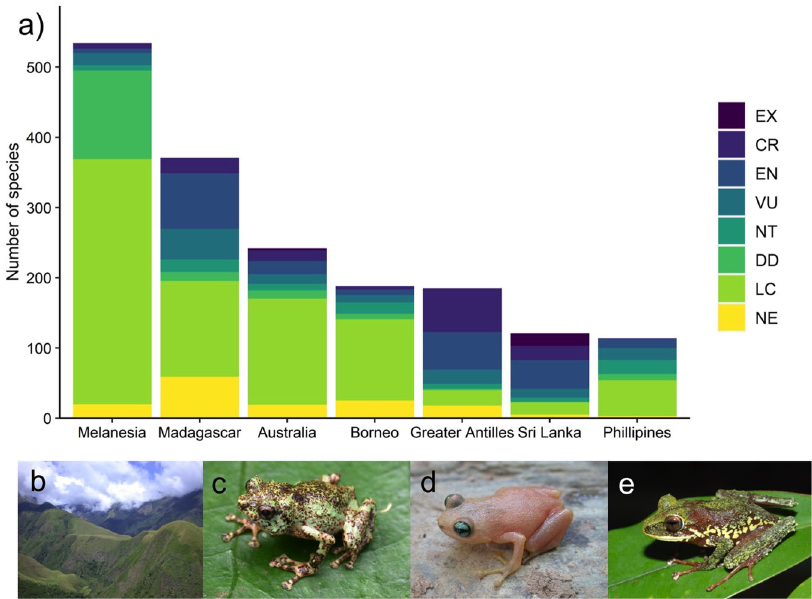
Fig. 4 The conservation status of Melanesian frogs. a Comparison of number of species in each IUCN threat category across Melanesia, other diverse insular regions, and the nearby continent of Australia. Melanesia has a proportionally low number of threatened taxa but high number of Data De fi cient taxa (EX Extinct, CR Critically Endangered, EN Endangered, VU Vulnerable, NT Near Threatened, DD Data De fi cient, LC Least Concern, NE Not Evaluated); b Slopes around Mt Simpson, Milne Bay Province, a hotspot of threatened frog diversity due to forest loss through conversion to anthropogenic grasslands; c Choerophryne sanguinopicta from Mt Simpson (Critically Endangered); d Oreophryne ezra from Rossel Island (Critically Endangered) and; e Cornufer citrinospilus from New Britain (Vulnerable). Photographs F. Kraus ( b – d ), S. Richards ( e